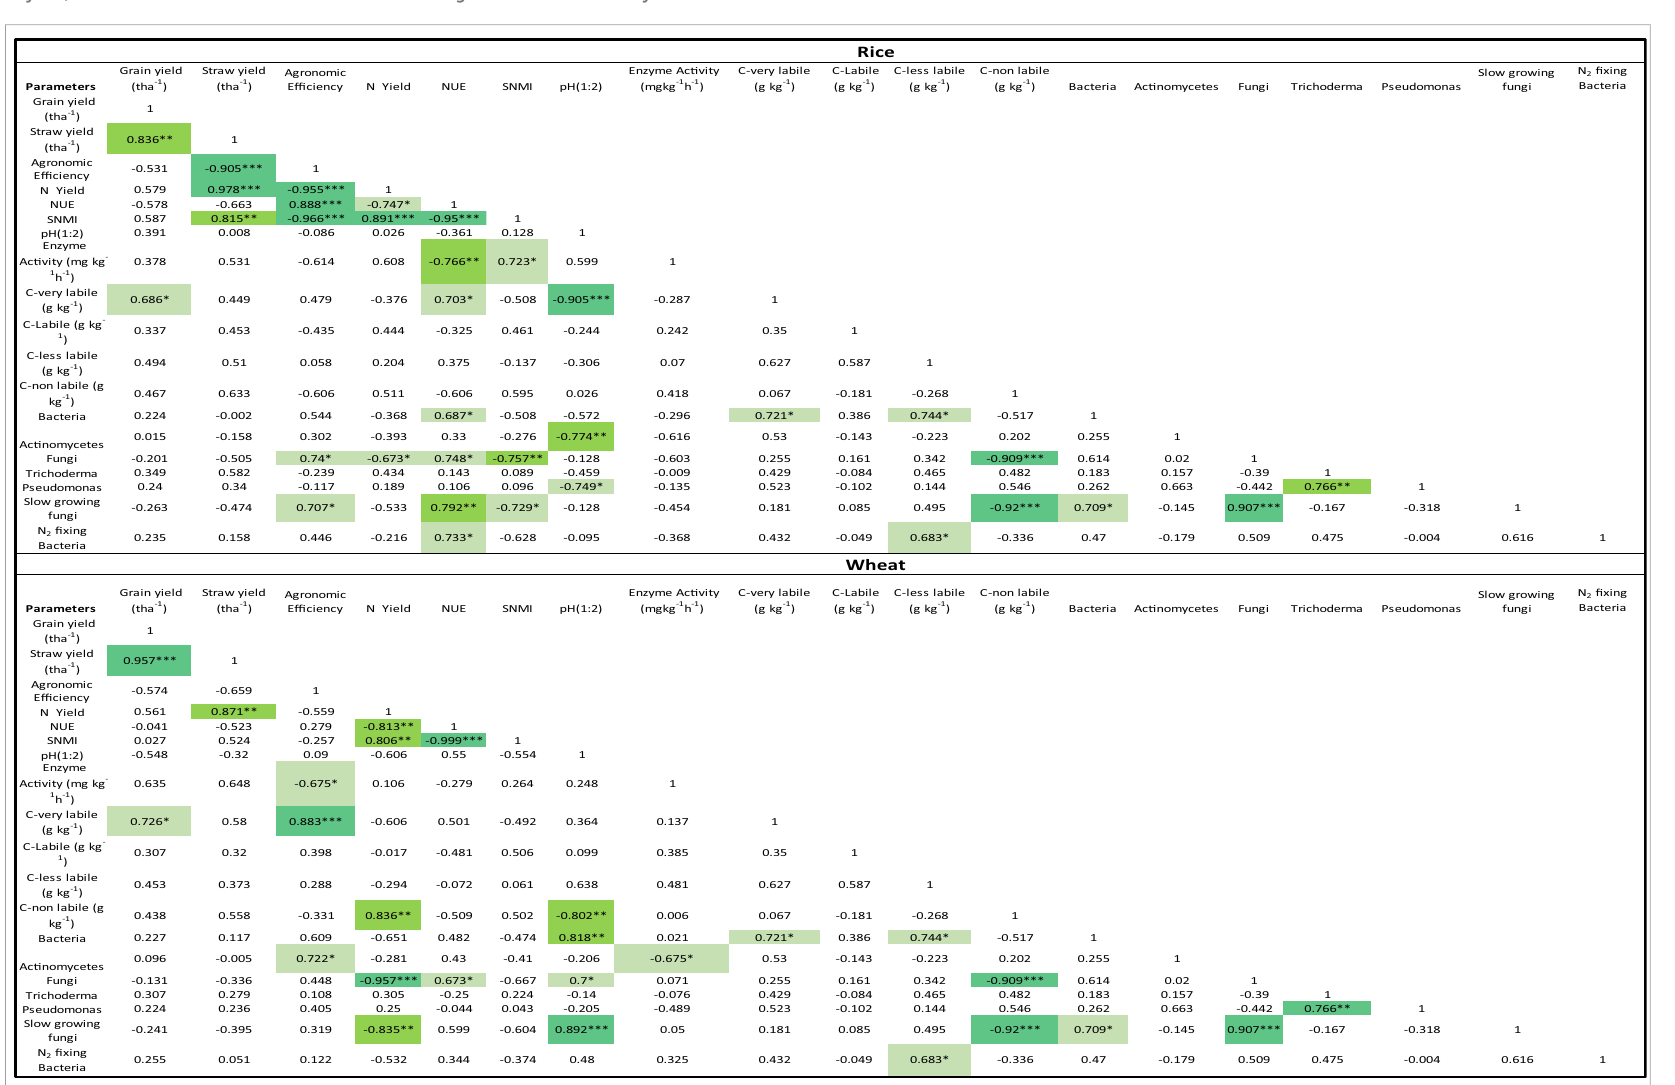
TABLE 2 Correlation matrix of various soil chemical and biological parameters with grain yield, and nitrogen use ef fi ciency parameters (N use ef fi ciency-NUE, sustainable N management index-SNMI, N-yield) recorded under different tested nutrient management in rice wheat system.